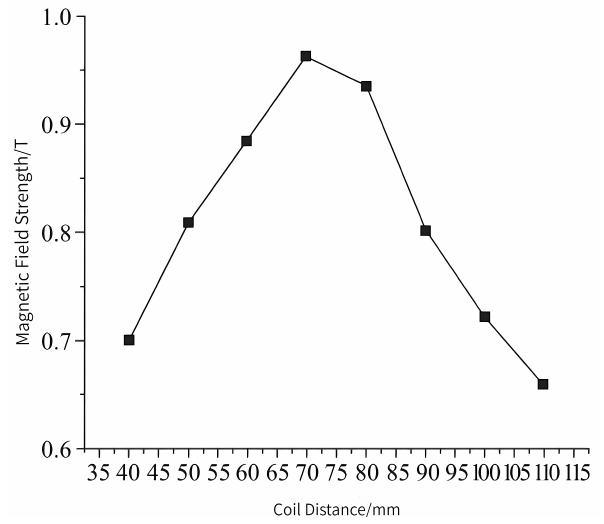
Figure 9. Changes in central magnetic induction intensity with coil distance.